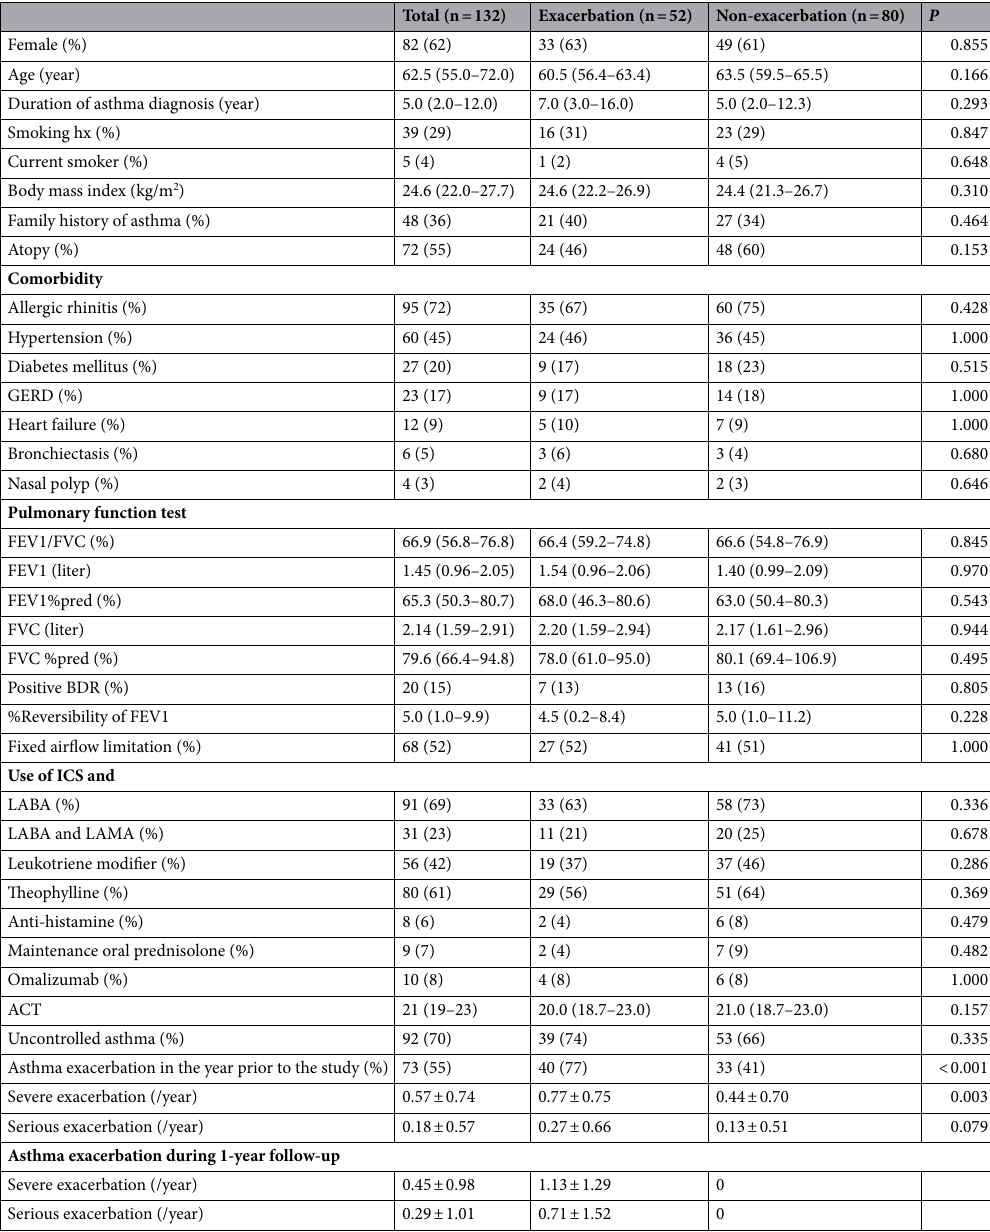
reversibility, FEV1 forced expiratory volume in one second, FVC forced vital capacity, GERD gastroesophageal reflux disease, ICS inhaled corticosteroid, LABA long-acting beta 2 agonist, LAMA long-acting muscarinic